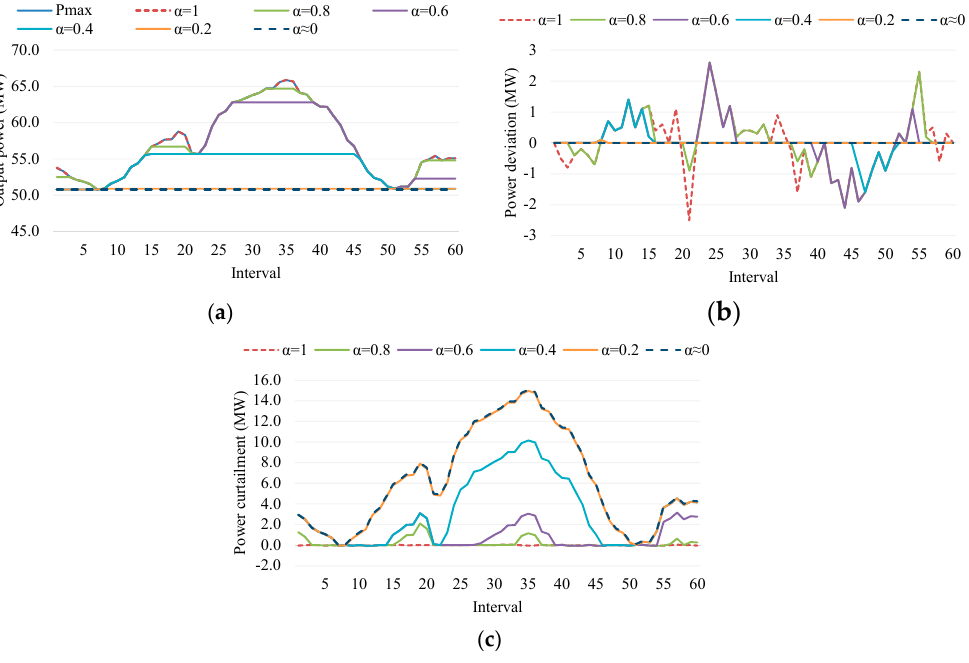
Figure 7. Effects of value of α on optimal results: ( a ) Output power of WF; ( b ) Output power deviation of WF; ( c ) Wind power curtailment.